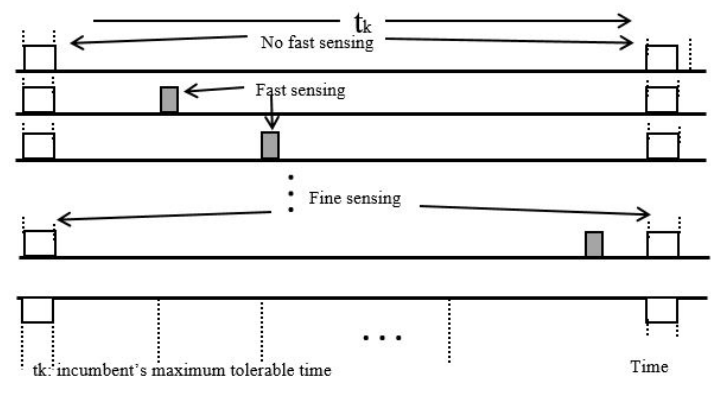
Figure 12. Approximate illustration of fast and fine Figure 12 . Approximate illustration of fast and fine sensing.